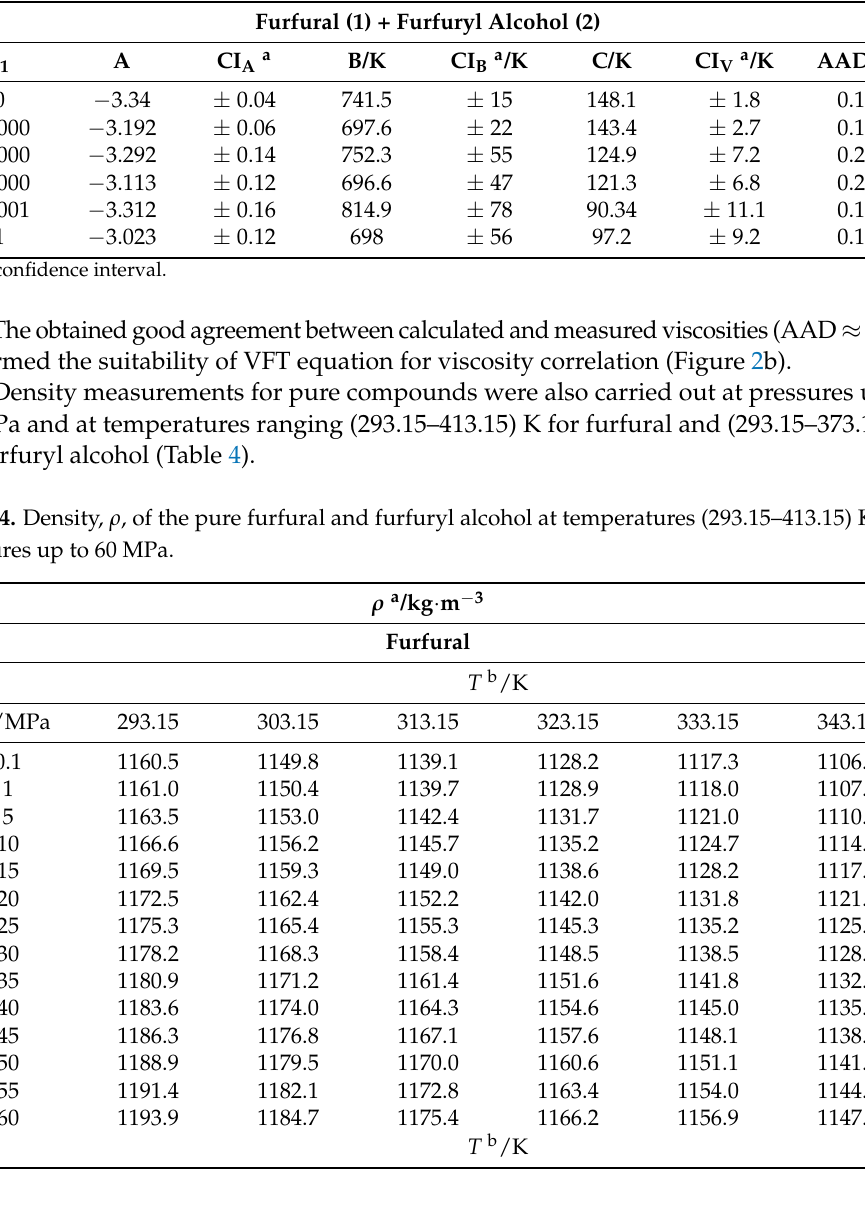
Table 3. Parameters of the Vogel–Fulcher–Tammann equation for furfural (1) + furfuryl alcohol (2) mixtures.